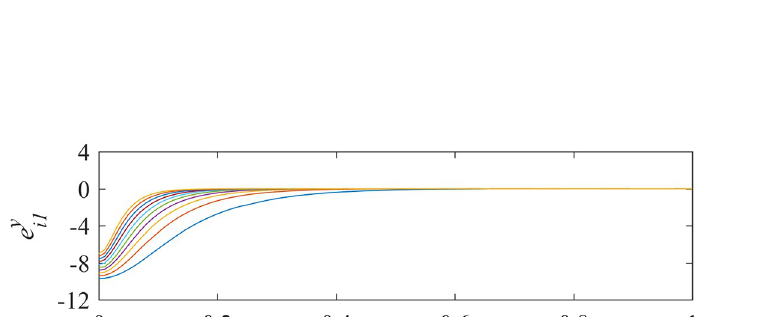
Fig 7. States of error system between the nodes and the isolate node in sub-network X (Eq (1)).